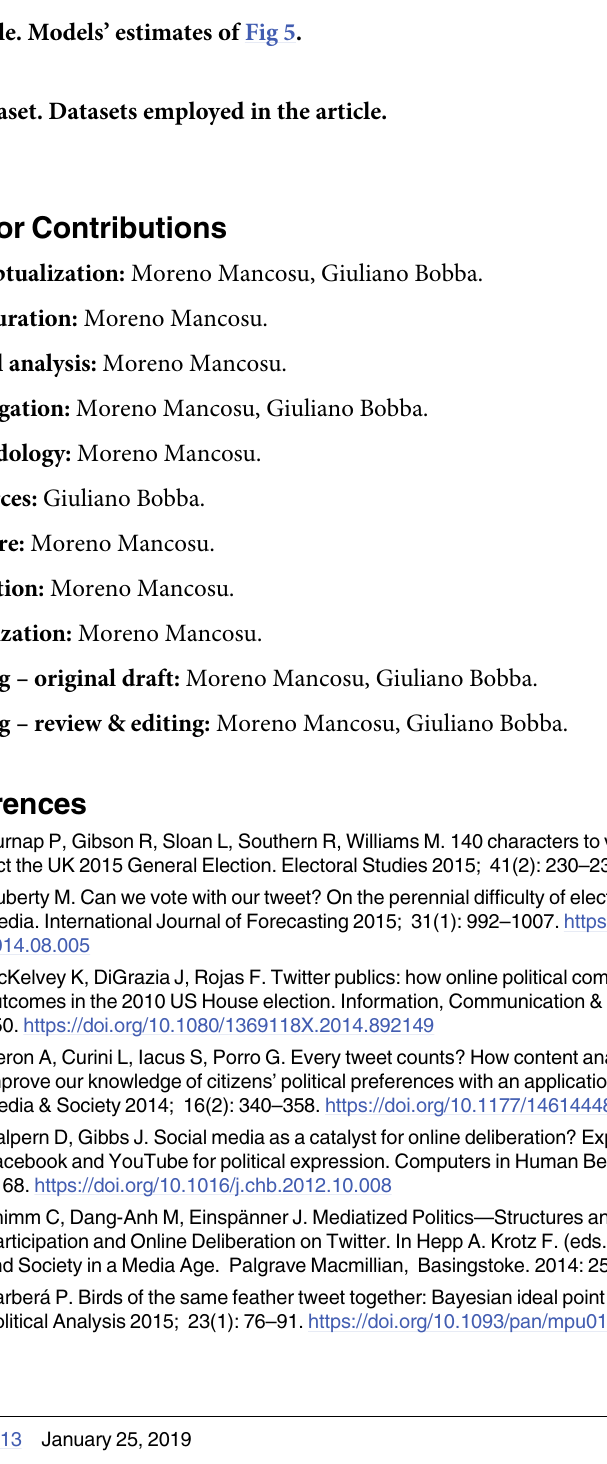
S2 Fig. Average age (left panel) and gender proportions (right panel) by party/leader con- sidered. S1 Table. Descriptive statistics of the datasets employed. (PDF) S2 Table. Models’ estimates of S2 Fig. (PDF) S3 Table. Models’ estimates of Fig 5. (PDF) S1 Dataset. Datasets employed in the article.